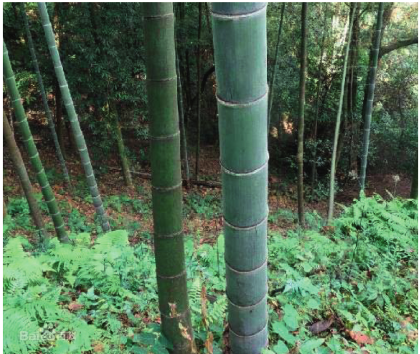
Figure 3: Phyllostachys pubescens .